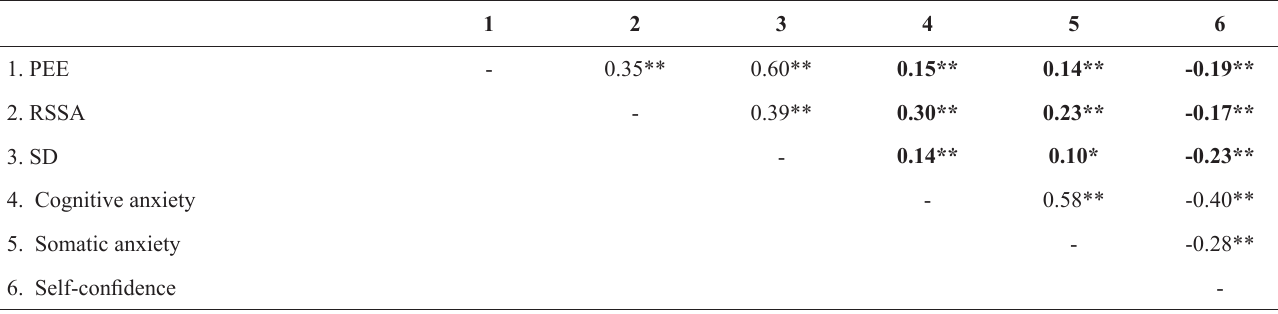
Table 3 - Correlations between the dimensions of burnout and pre-competitive